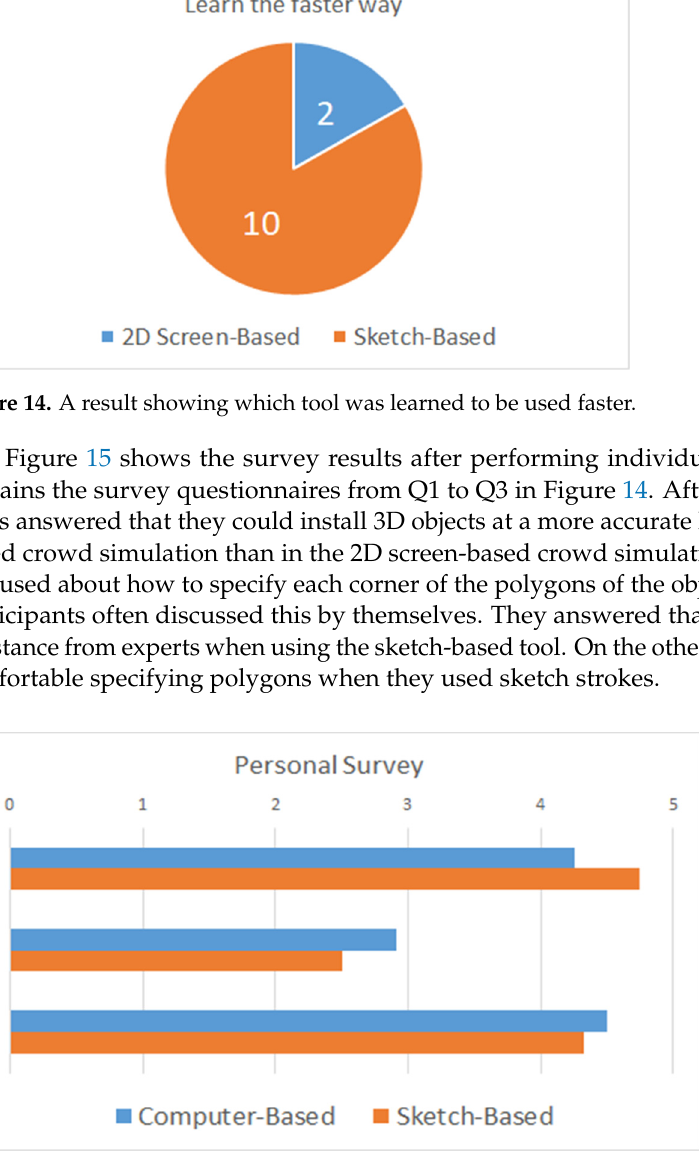
Table 4. Average time to create environment.